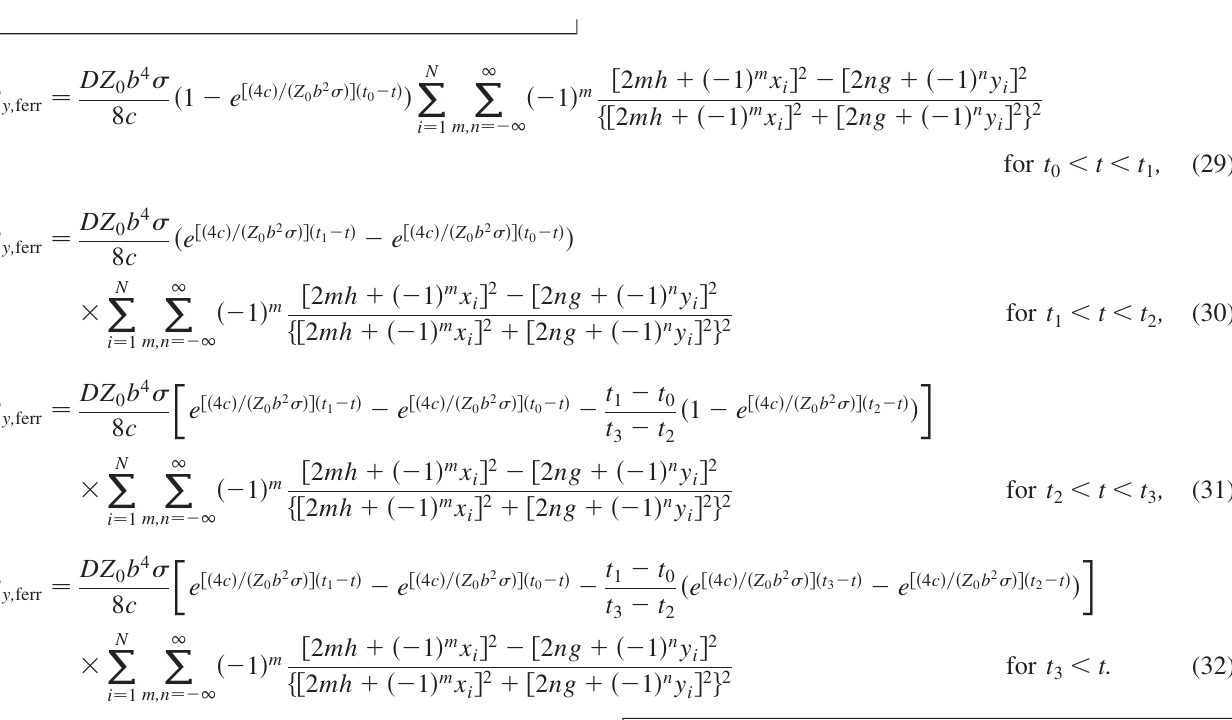
ð¼ 300 (cid:5) s Þ (cid:1) 2 ð¼ 800 (cid:5) s Þ (cid:1) 3